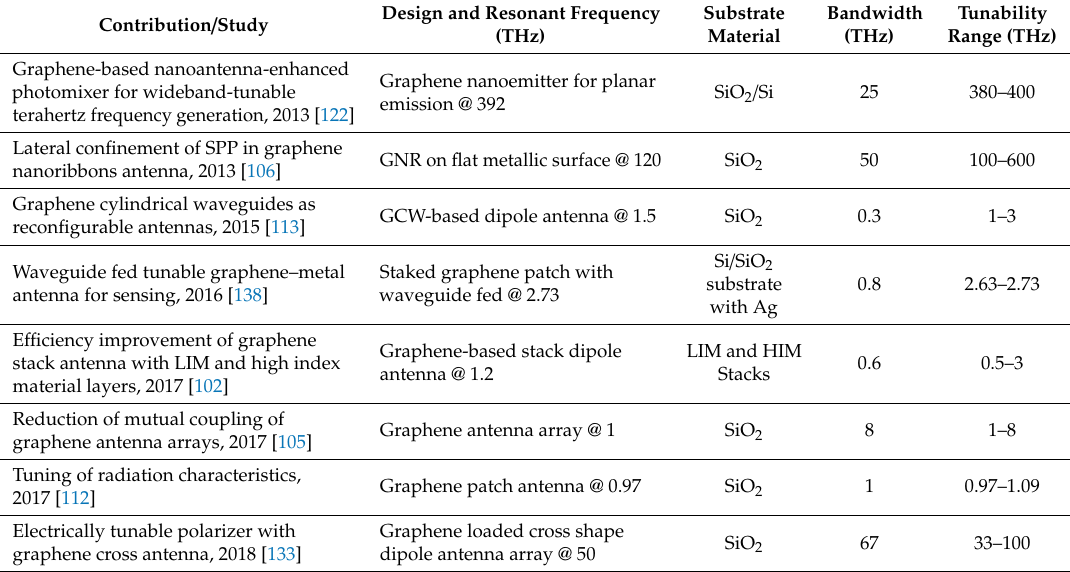
Table 1. Summary of the various design performances and their contributions discussed in Section